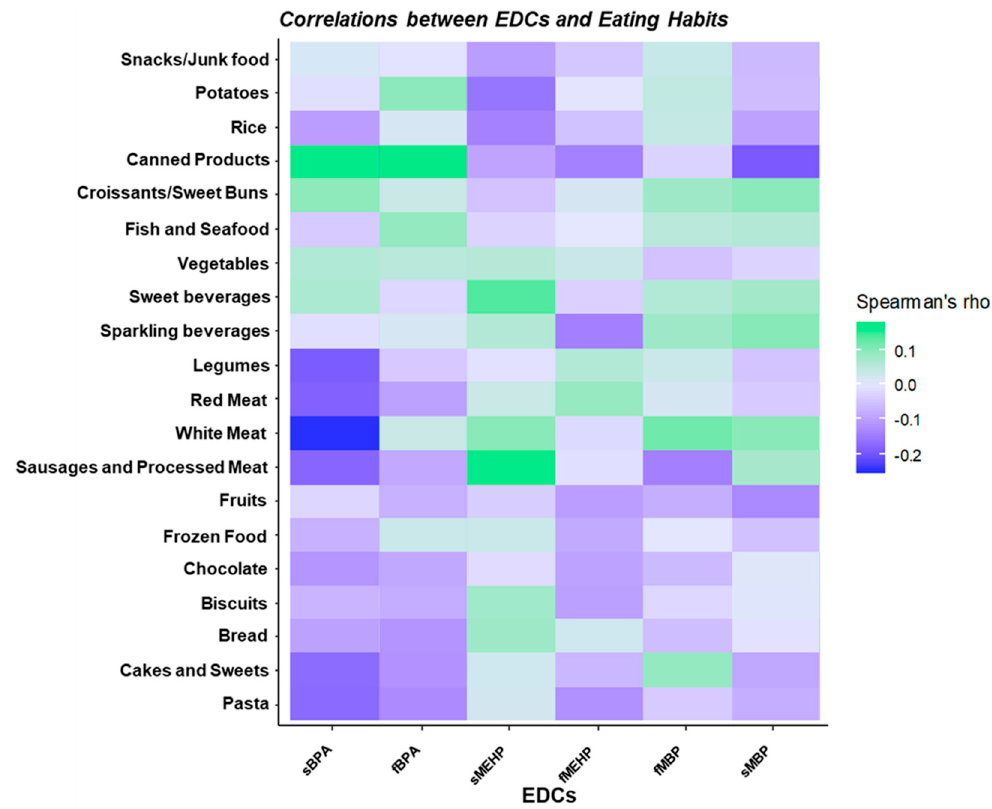
Figure 3. Spearman’s correlations between food consumption (high or low consumption) and serum and follicular fluid bisphenol A (BPA), monoethylhexyl phthalate (MEHP) and monobutyl phthalate (MBP). sBPA: serum BPA; fBPA: follicular fluid; sMEHP: serum MEHP; fMEHP: follicular fluid MEHP; sMBP: serum MBP; fMBP: follicular fluid MBP. Table 3. Median and 25th–75th percentile (Q1–Q3) and detection rates of investigated endocrine disrupting chemicals (EDCs). FF: follicular